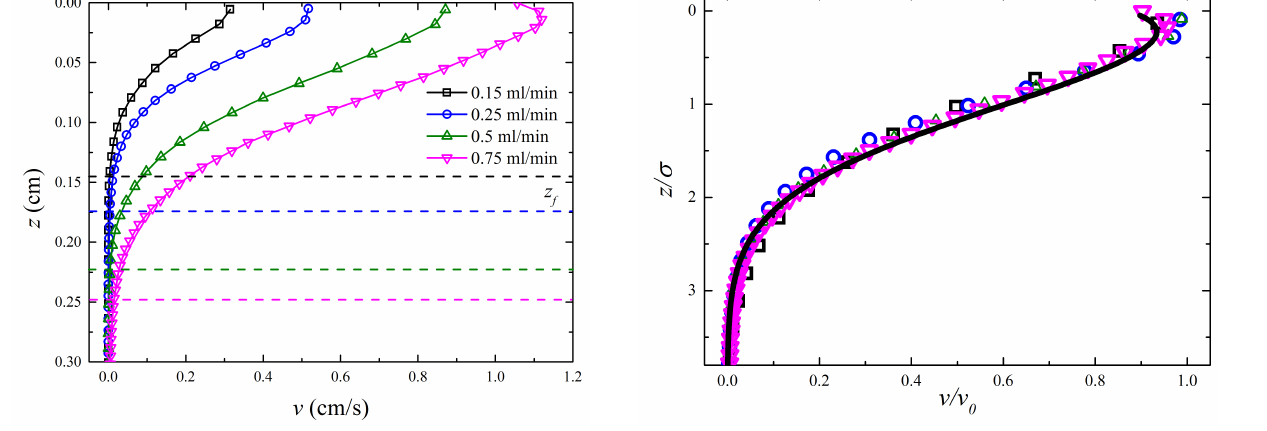
Figure 3. Velocity as a function of depth in the Gaussian flow regime for h = 3 mm. Dashed lines correspond to z f shown in Figure 2.